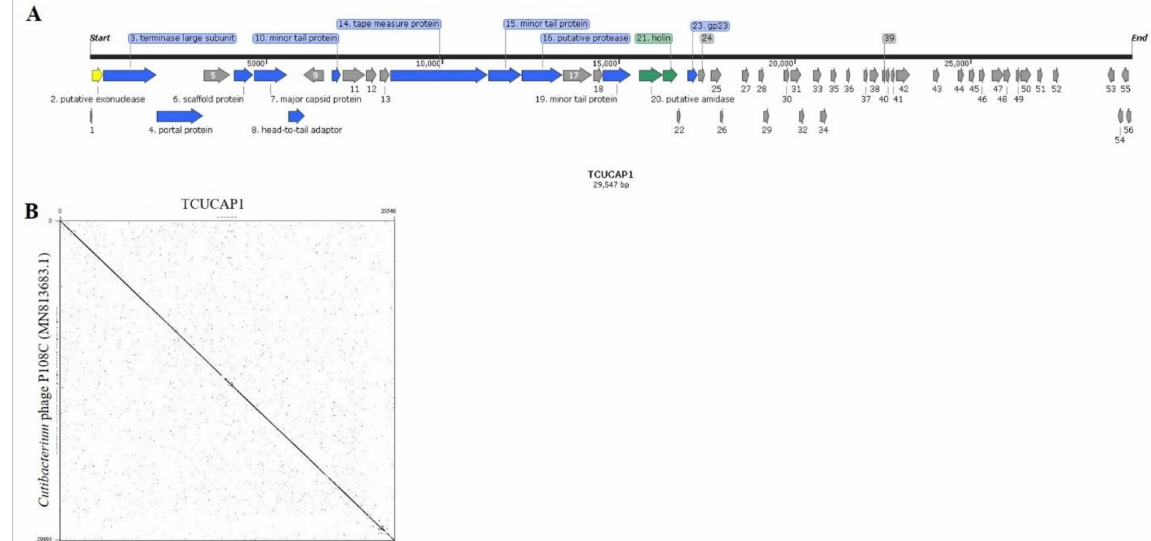
Figure 2. ( A ) Organization of the TCUCAP1 genome. ORFs coding for proteins involved in structure and assembly are marked in blue; ORFs coding for proteins involved in lysogeny are marked in yellow; ORFs coding for enzymes involved in host lysis are marked in green; ORFs coding for hypothetical proteins are marked in grey. Arrows indicate the direction of transcription and translation. The figure was generated using the SnapGene program, http://www.snapgene.com (accessed on 21 April 2021). ( B ) Dot plot nucleotide sequence comparisons of TCUCAP1 and phage P108C were compared using the dot plot program